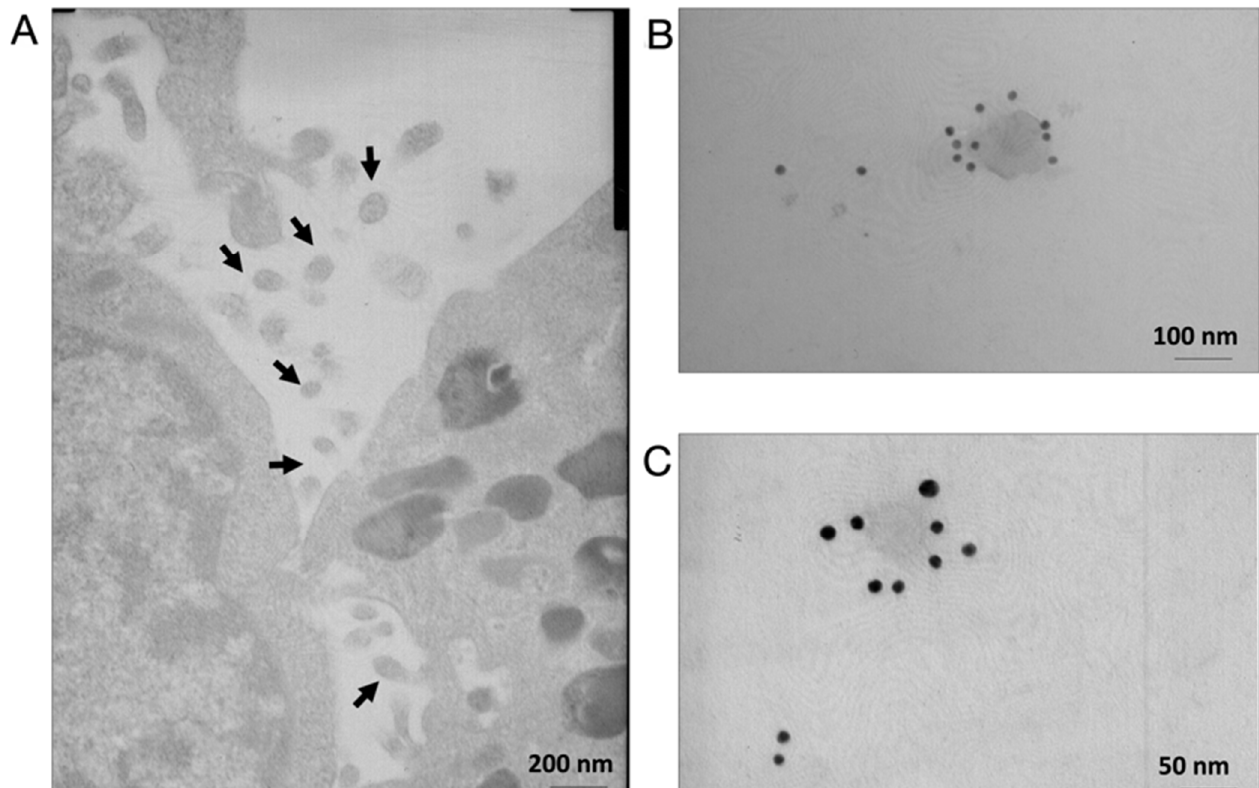
Figure 1. C2C12 cell lines secrete extracellular vesicles (EVs). ( A ) Electron microscopy analyses of 3D cultures of C2C12 cell lines show the presence of budding intermediates (nascent vesicles, black arrows) at the plasma membrane or already budded vesicles with an average diameter of 80 nm (black arrows). ( B , C ) Transmission electron microscopy showing immunogold labelling of Alix (a known marker of small EVs) in nanovesicles from the 3D cultures of C2C12 cell lines (10 nm gold particles).